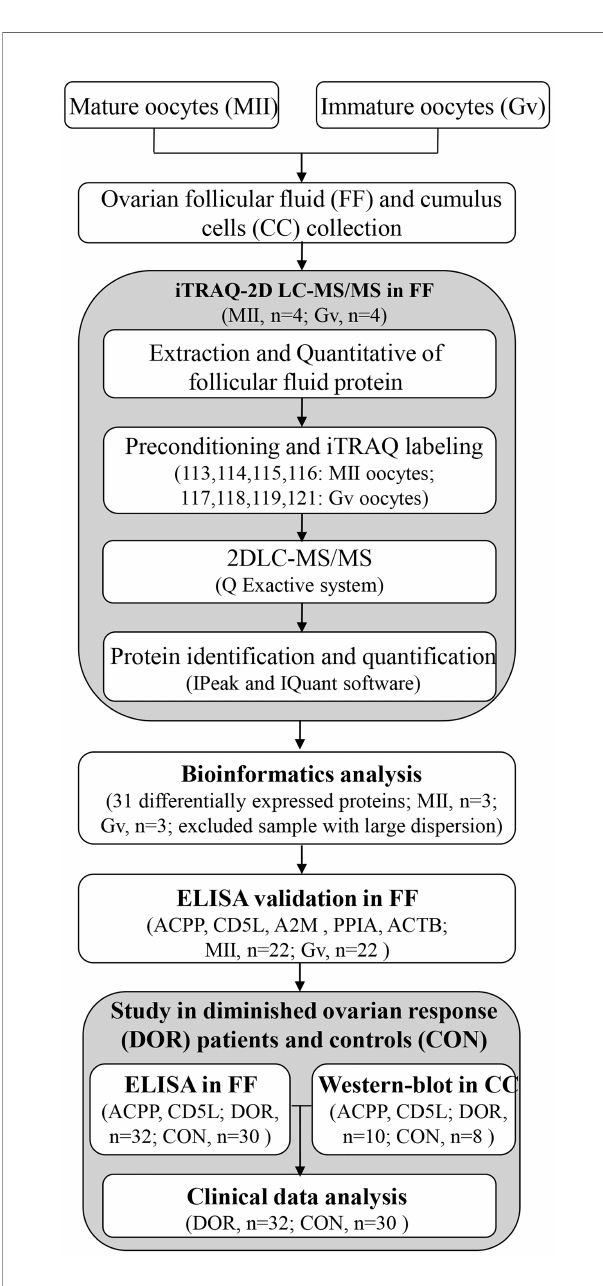
FIGURE 1 | The work fl ow for ovarian follicular fl uid biomarkers of maturation and quality of